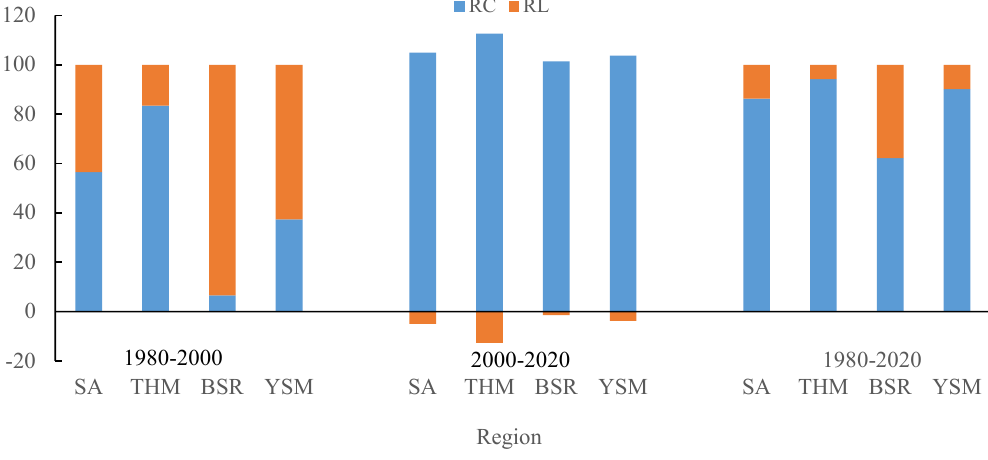
Figure 10. Contribution rates of land use/land cover and climate to the water yield change of different regions during 1980–2000, 2000–2020, and 1980–2020 (SA—Study area, THM—Taihang Mountain, BSR—Bashang region, YSM—Yanshan Mountain; RC—rate of climate, RL—rate of LULC). The contribution of climate to the water yield increased in the THM, BSR, and YSM from 83.48% to 112.63%, 6.59% to 101.43%, and 37.41% to 103.73% in 1980–2000 and 2000–2020, respectively. The contribution of LULC to water yield in the THM, BSR, and YSM